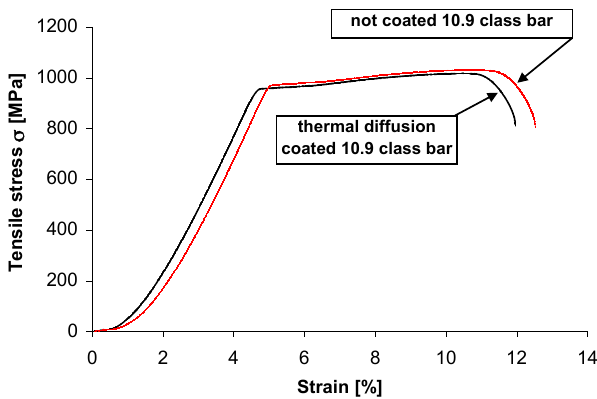
Figure 7. Tensile stress-displacement relationship curve of coated and uncoated 10.9 grade threaded bar. Table 2. Results of tensile strength test of coated and uncoated 10.9 grade threaded bar. Type of Threaded Bar Sample Number R m [MPa] R p0,2 [MPa] R p0,2 / R m [MPa] not coated 10.9 grade